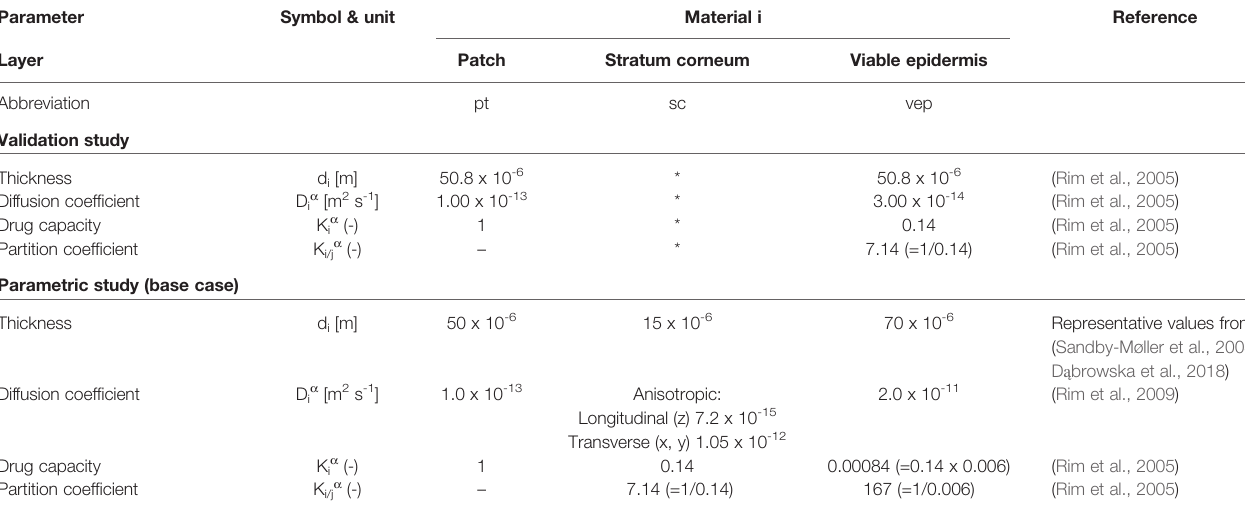
TABLE 3 | Material transport properties used in the model for different con fi gurations for